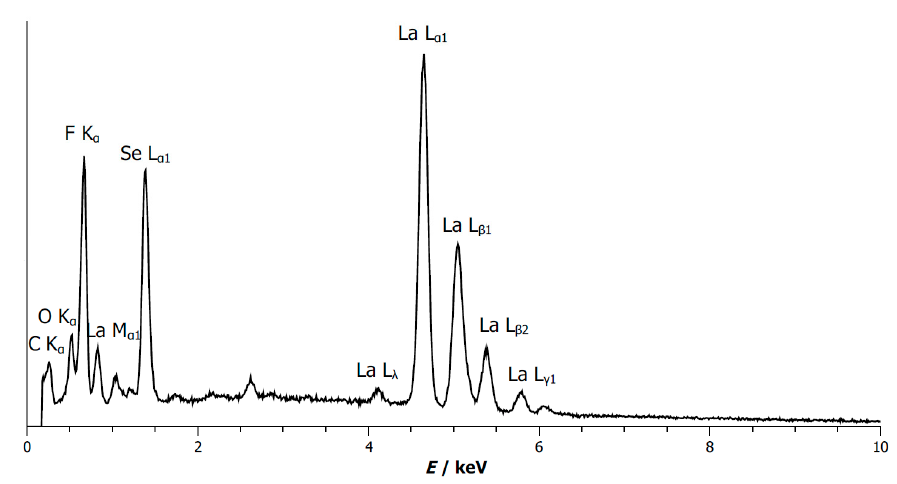
Figure 6. The energy-dispersive X-Ray spectrum (EDXS) of a single crystal of B-type La 2 OF 2 Se.